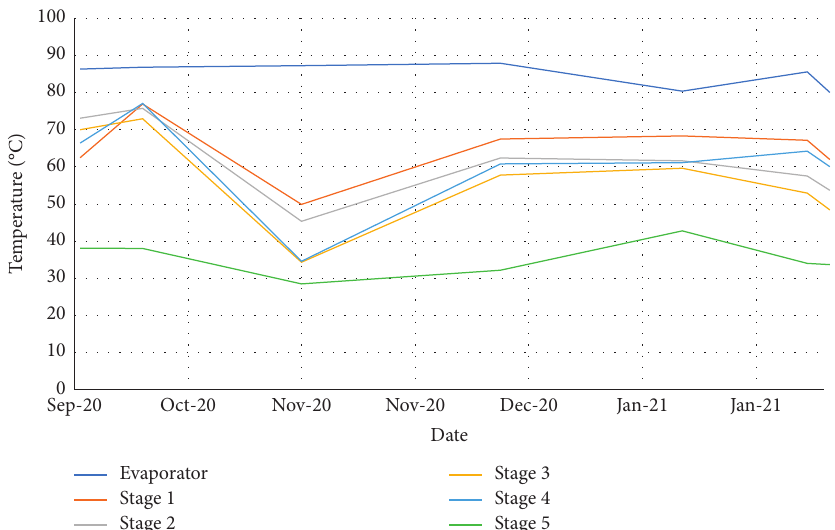
Figure 6: SW temperature versus stage numbers.